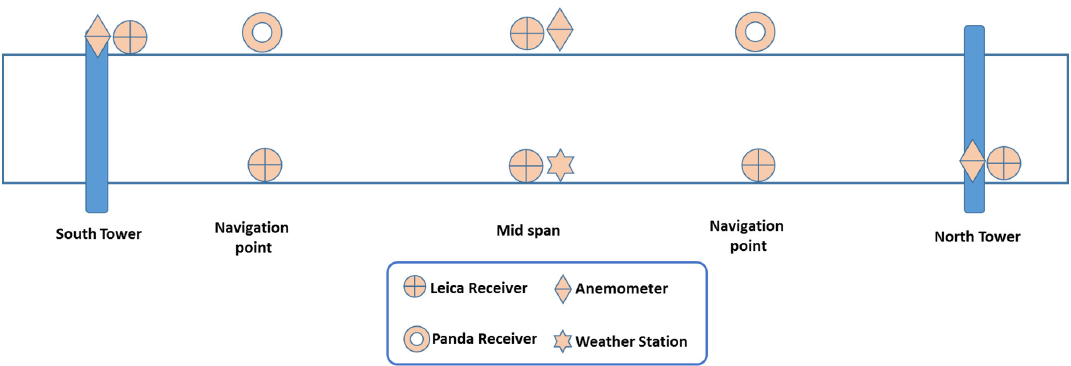
Figure 8. Current distribution of sensors on the FRB.